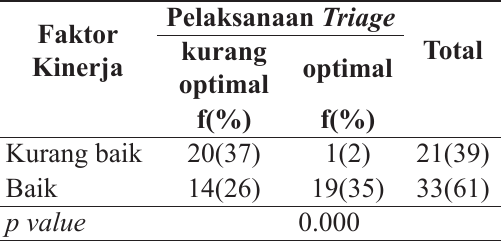
Tabel 2. Tabulasi silang faktor kinerja dan